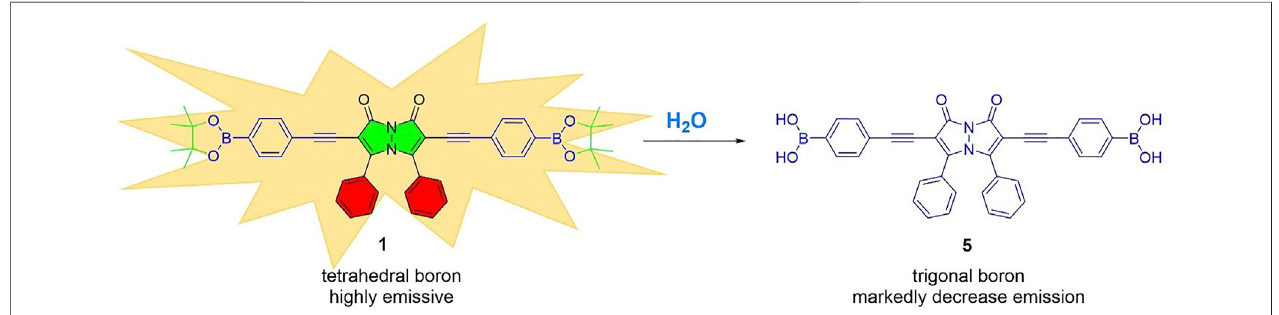
FIGURE 5 | The hydrolysis of boronate ester 1 to boronic acid 5 , which likely is responsible for water-induced fl uorescence decreases.